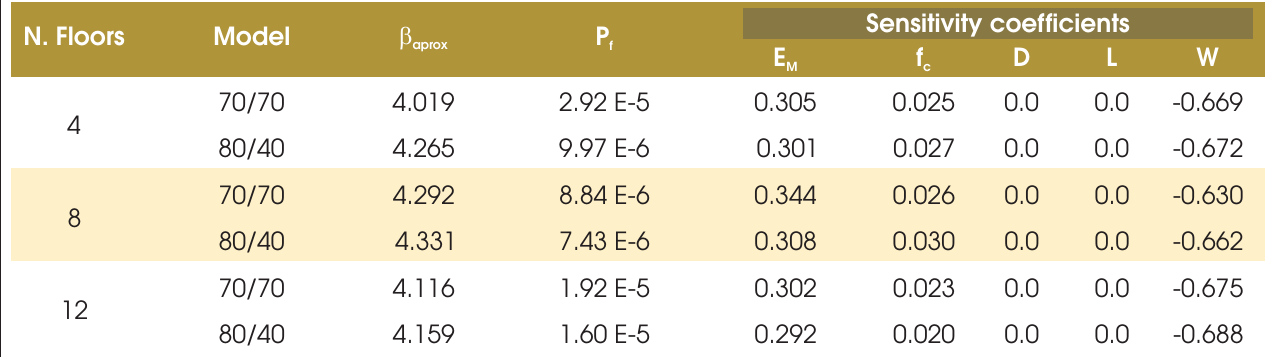
Table 6 – Results for 50-year extreme live load combined with annual maximum wind load N. Floors